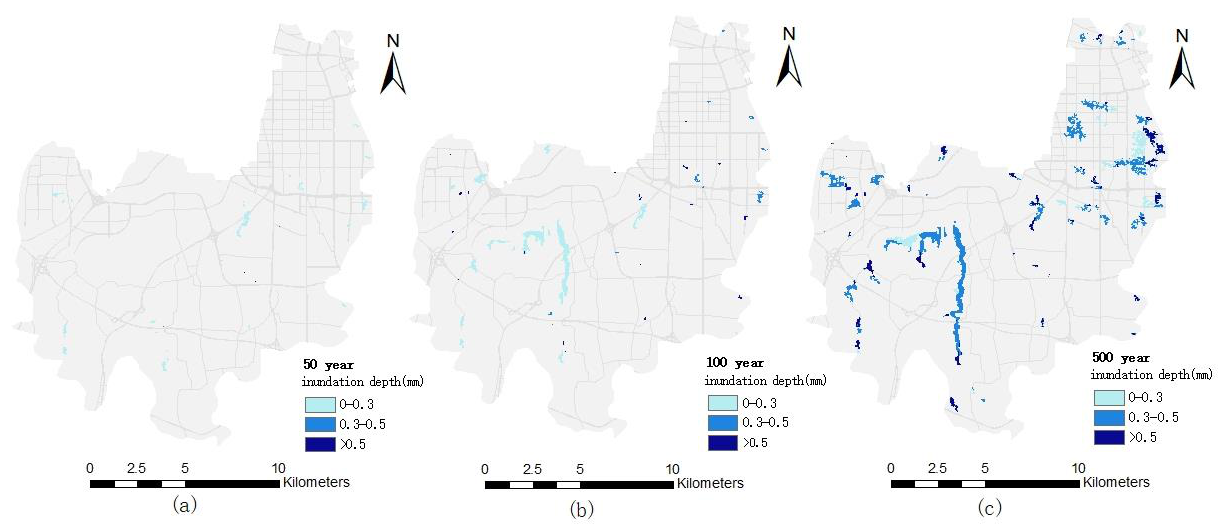
Figure 4. Simulation map of inundation area and depth under different pluvial flooding scenarios in the Erqi District: ( a ) the 50-year pluvial flooding scenario; ( b ) the 100-year pluvial flooding scenario; ( c ) the 500-year pluvial flooding scenario.